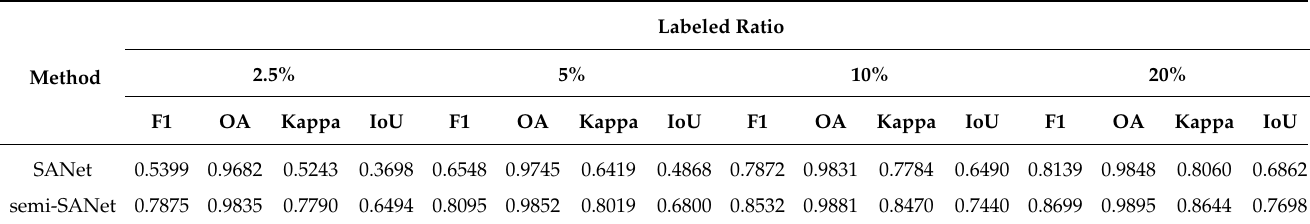
Table 4. The experimental results on the LEVIR2000